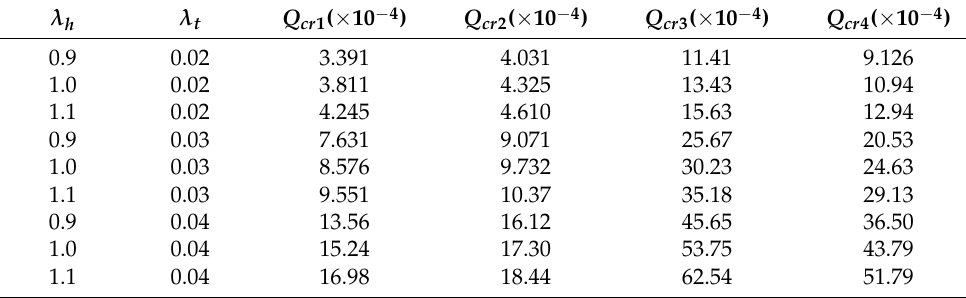
Table 7. Four critical loads under different λ h and λ t ( β = ± 0.25